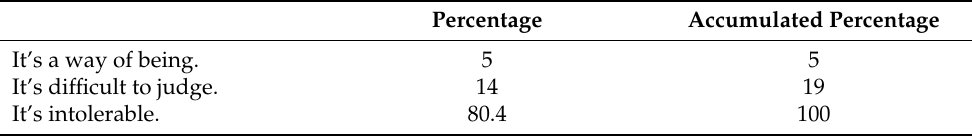
Table 4. Judgment distribution toward ethnic and racial discrimination. Percentage Accumulated